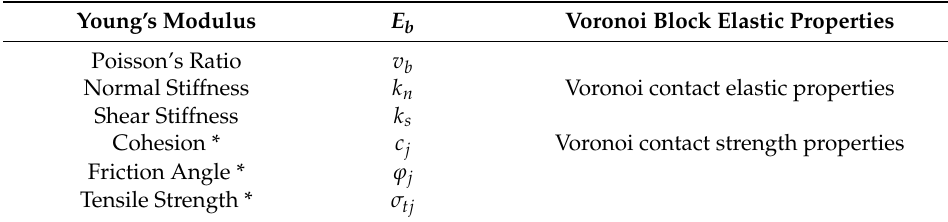
Table 1. Voronoi model micro-properties